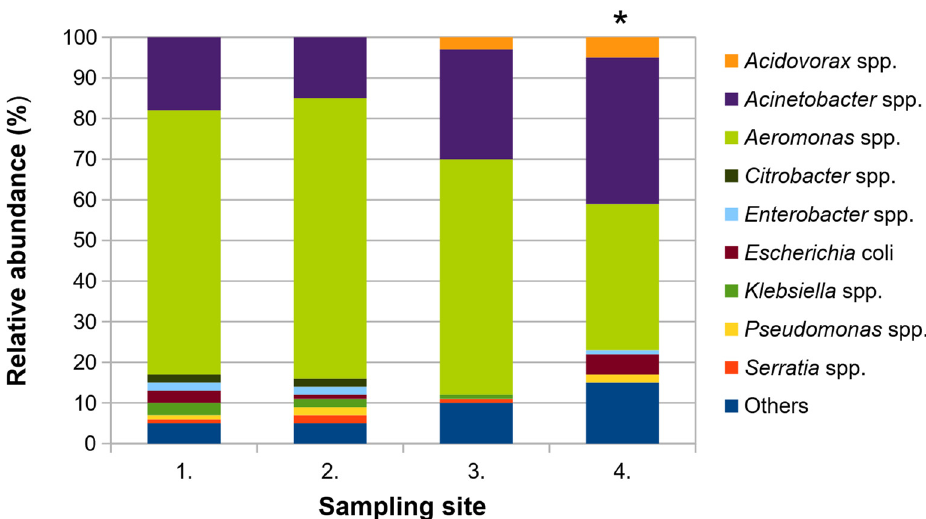
Figure 1. The composition of cultivable bacterial communities in di ff erent stages of the wastewater treatment process in Kokšov-Bakša, (Košice, Slovakia). The category “Others” groups bacteria whose relative abundance was within the community below 2%, such as Achromobacter spp., Kluyvera spp., Lactobacillus spp., Lactococcus spp., Leuconostoc spp., Providencia spp., Raoultella spp. and unreliable identi fi ed isolates by MALDI-TOF MS. 1.—in fl ow, 2.—mechanical wastewater treat- ment, 3.—biological wastewater treatment, 4.—out fl ow. * Signi fi cant reduction in the number of Aeromonas spp. and signi fi cant increase in the number of Acinetobacter spp. during the wastewater treatment process (Chi-square test, p < 0.05).